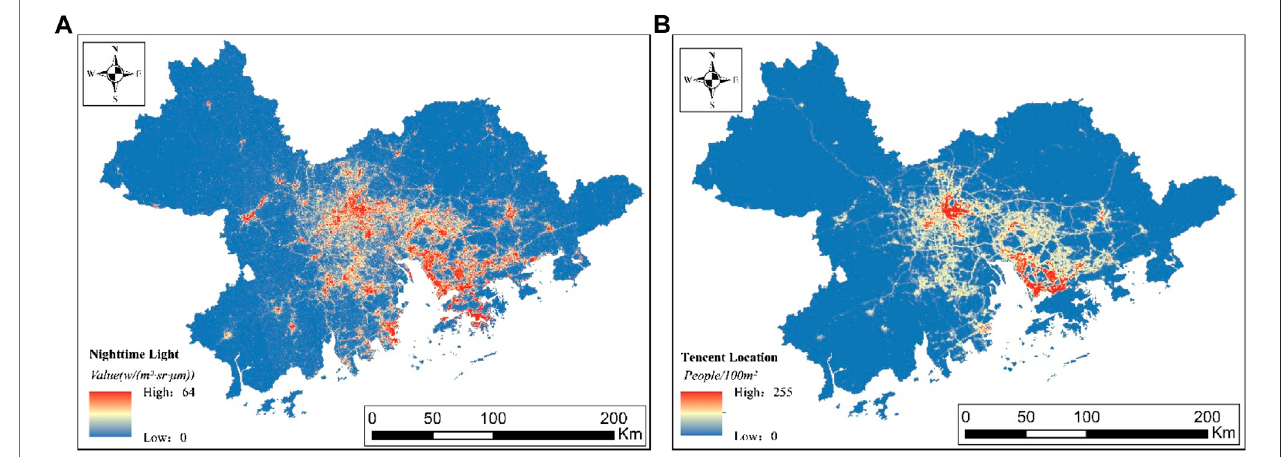
FIGURE 2 | (A) Pre-processing results of NTL data. (B) Population fl ow results in